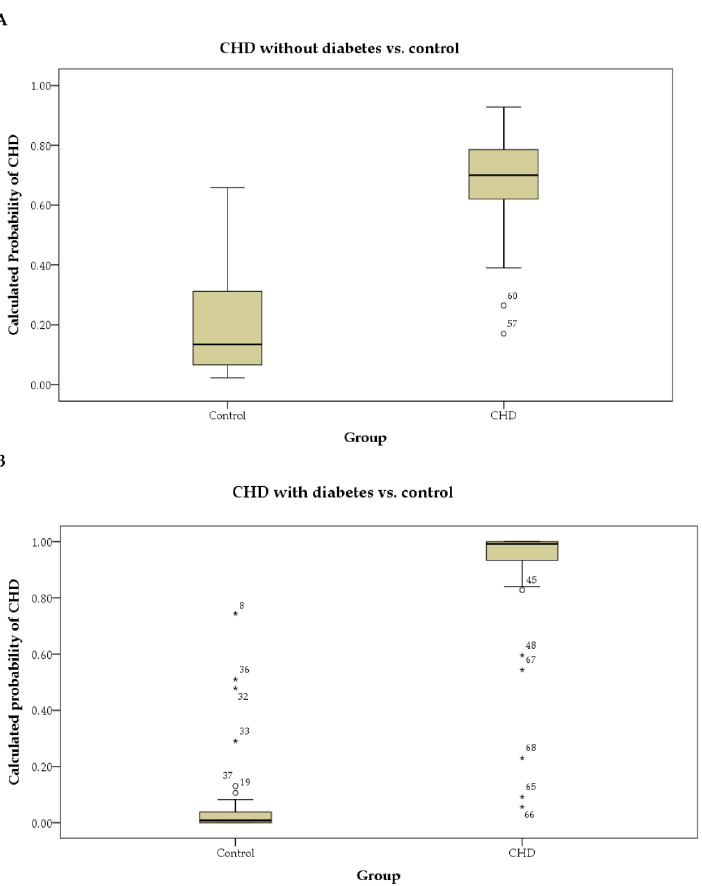
Figure 3. Subgroup analysis with classification models for CHD patients ( A ) without and ( B ) without diabetes in box plot.